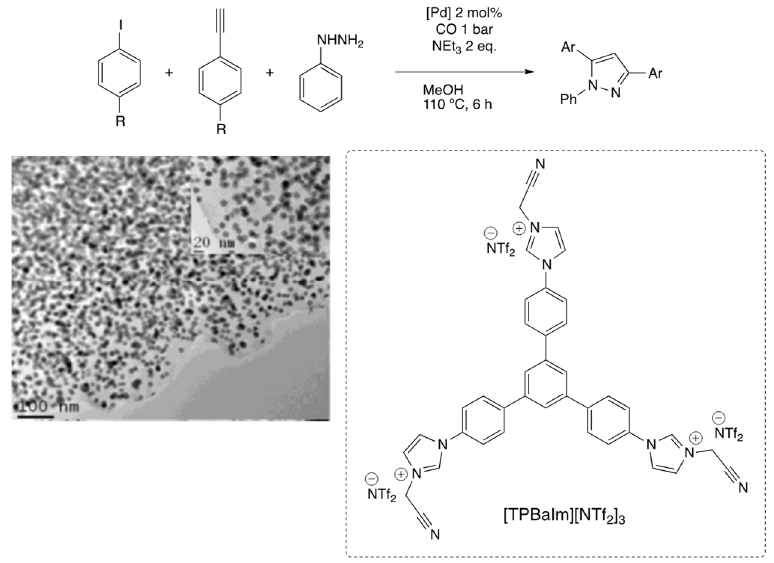
Figure 7. TEM image of Pd@CN and four-component synthesis of triarylpyrazoles [91]. Reproduced from [91] with permission from the American Chemical Society.